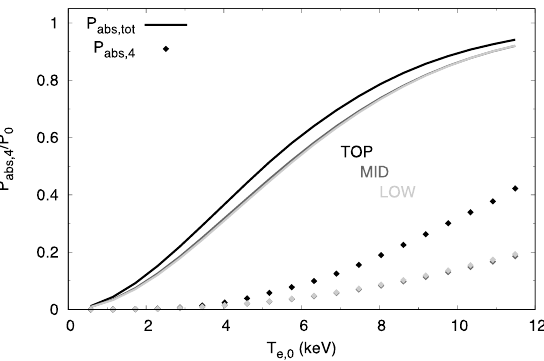
Fig. 7b. Total and power absorbed by n=4 harmonic resonance for n e,0 =1.0∙10 19 m -3 ; solid lines corresponds to dots in Fig. 5.